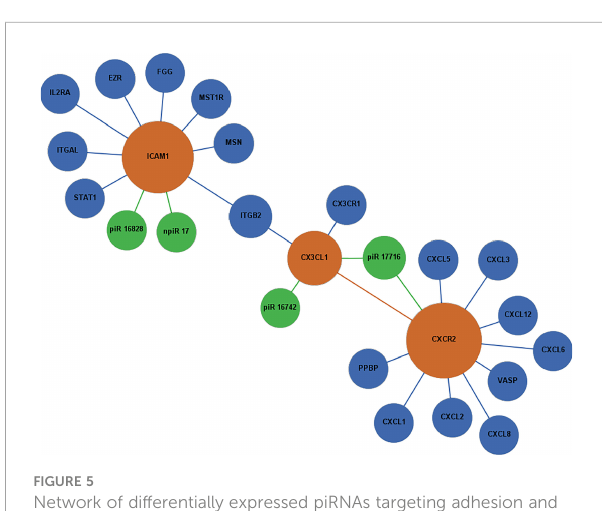
FIGURE 5 Network of differentially expressed piRNAs targeting adhesion and chemokine signaling molecules operating during T. cruzi challenge of PHCF. Biological interaction networks were created using predicted piRNA targets (ICAM1, CX3CL1, and CXCR2) as primary seed nodes to query pathway and interaction data sources out to one degree of biological interaction. Primary seed notes are denoted as orange circles. Expansion notes (blue) with a predicted binding target of DE piRNAs